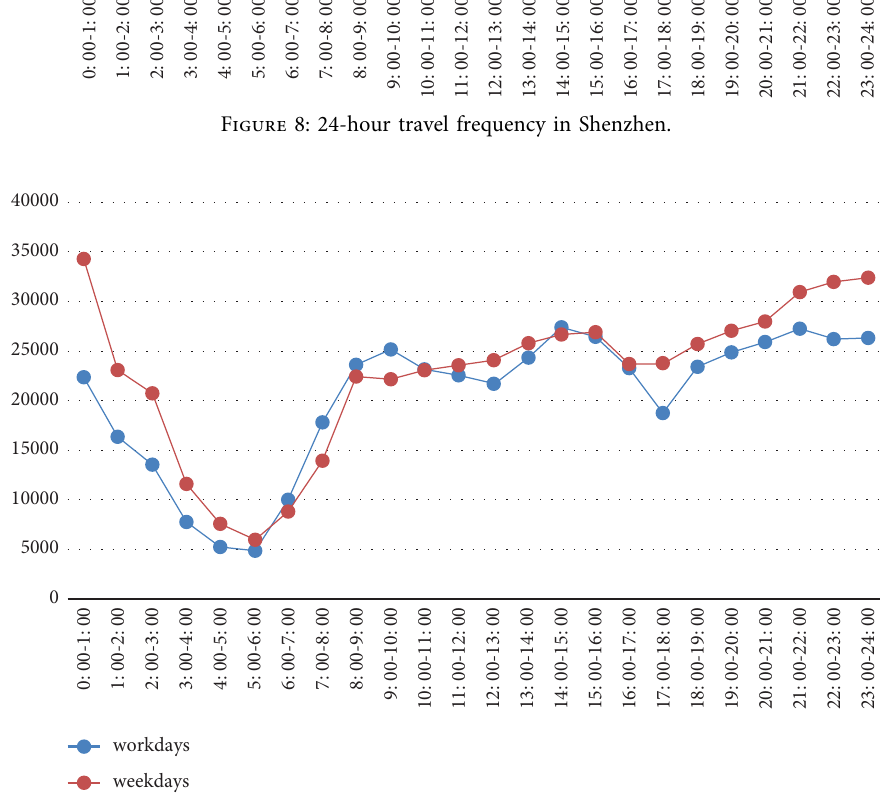
Figure 9: Comparison between work days and weekends in Shenzhen.